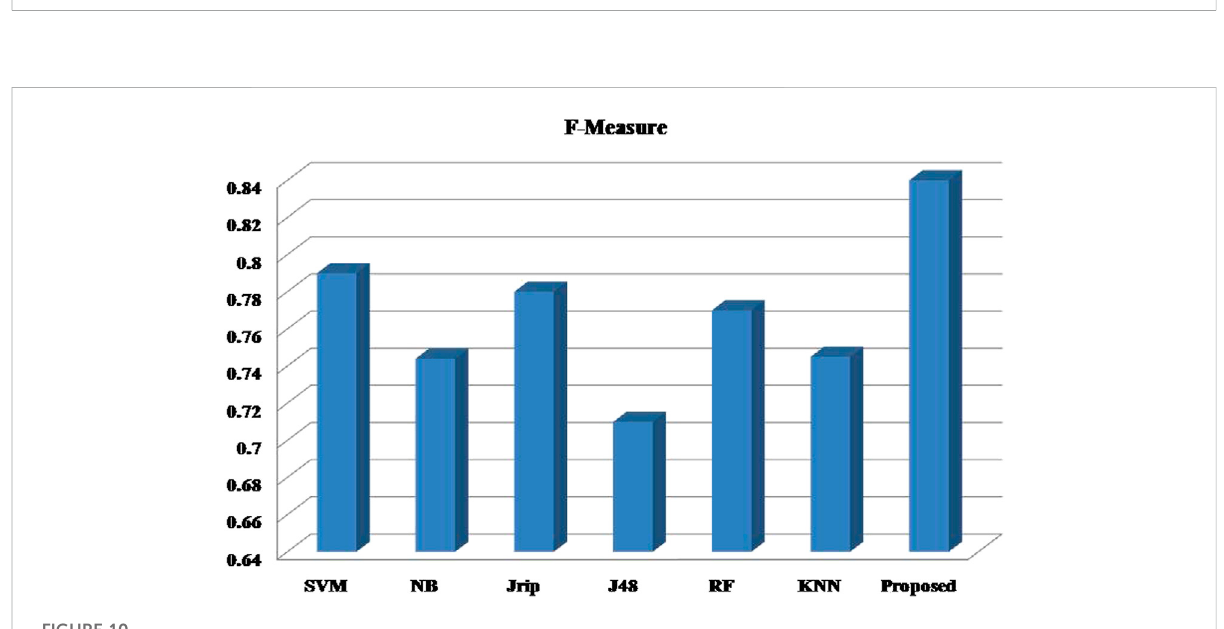
FIGURE 10 Experimental results for